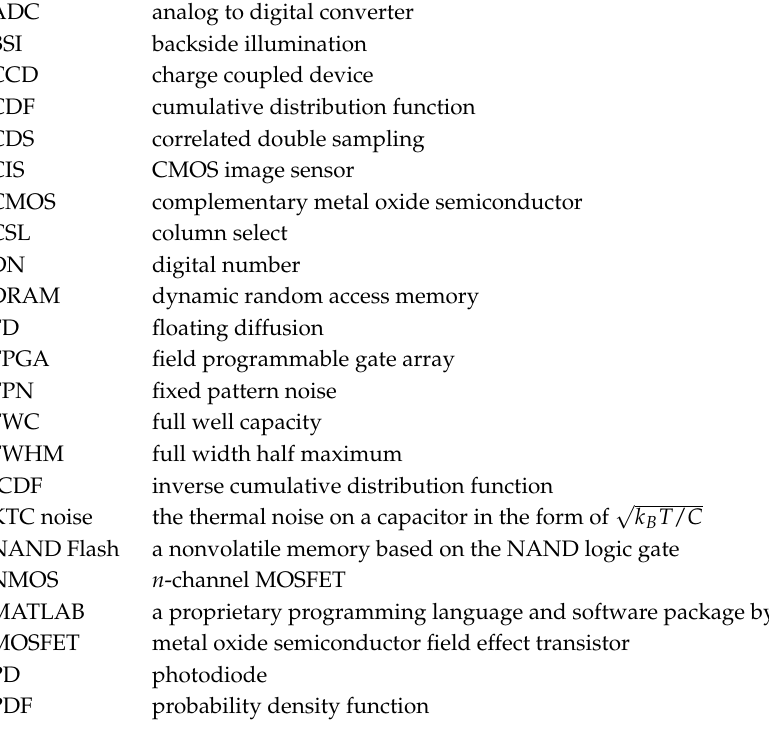
noise histogram in